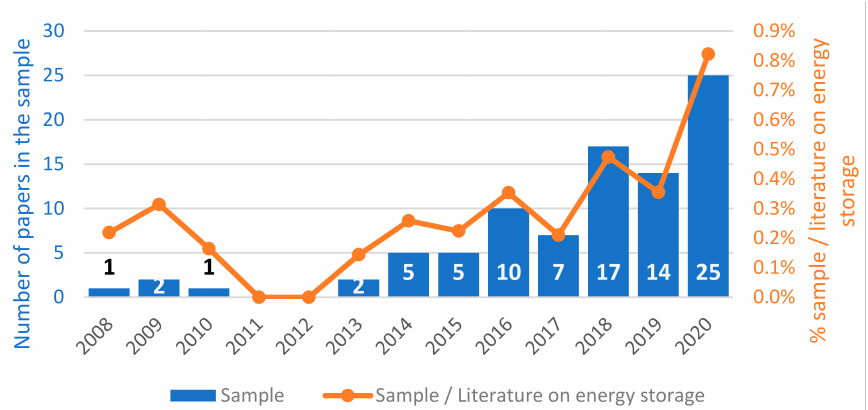
Figure 3. Yearly distribution of paper sample. Note: three early papers published before 2008 are not represented in the figure; these papers were published in 1979, 1985, and 2001.